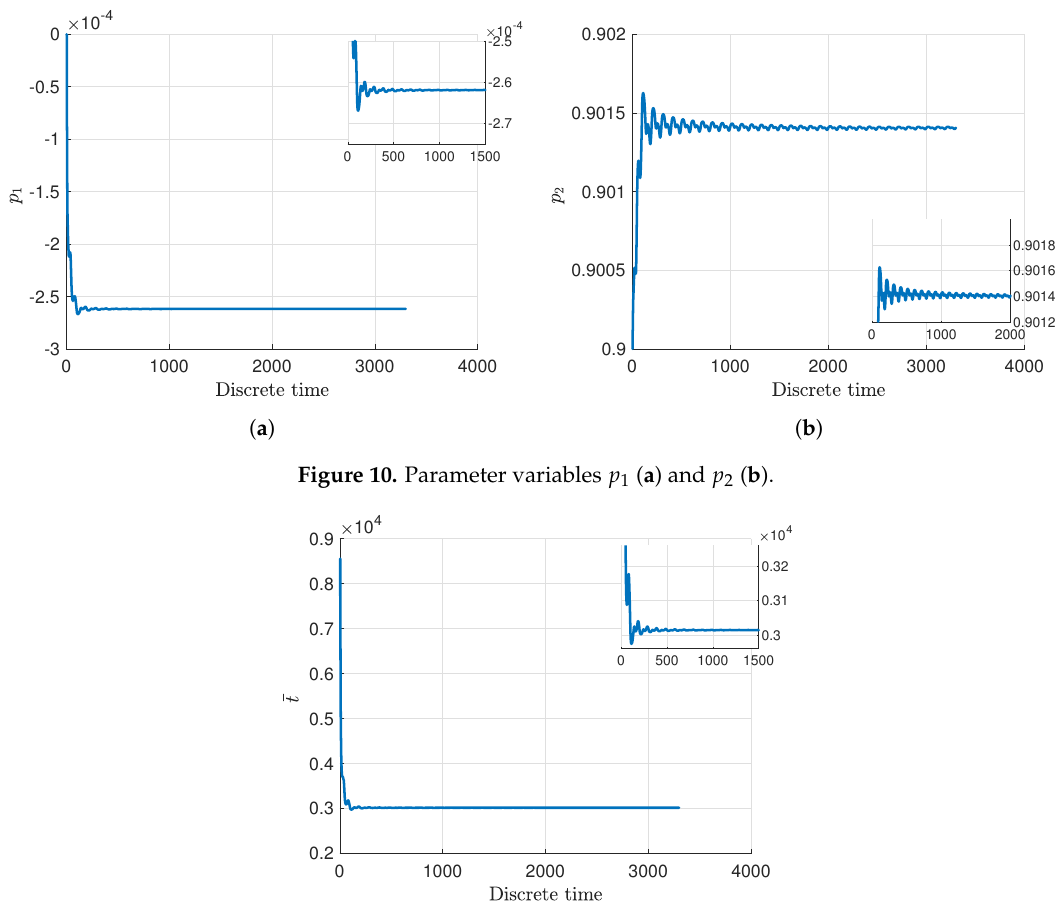
Figure 11. Time of the AGV remaining